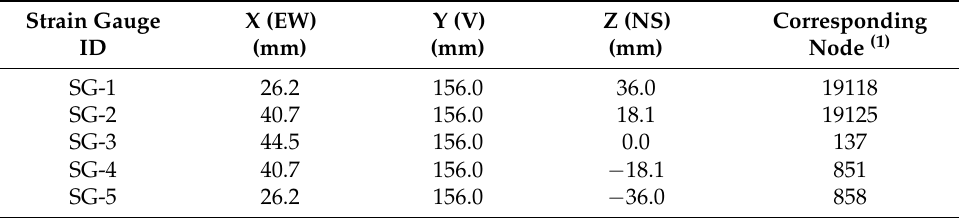
Table 6. Coordinates of the attached strain gauges.